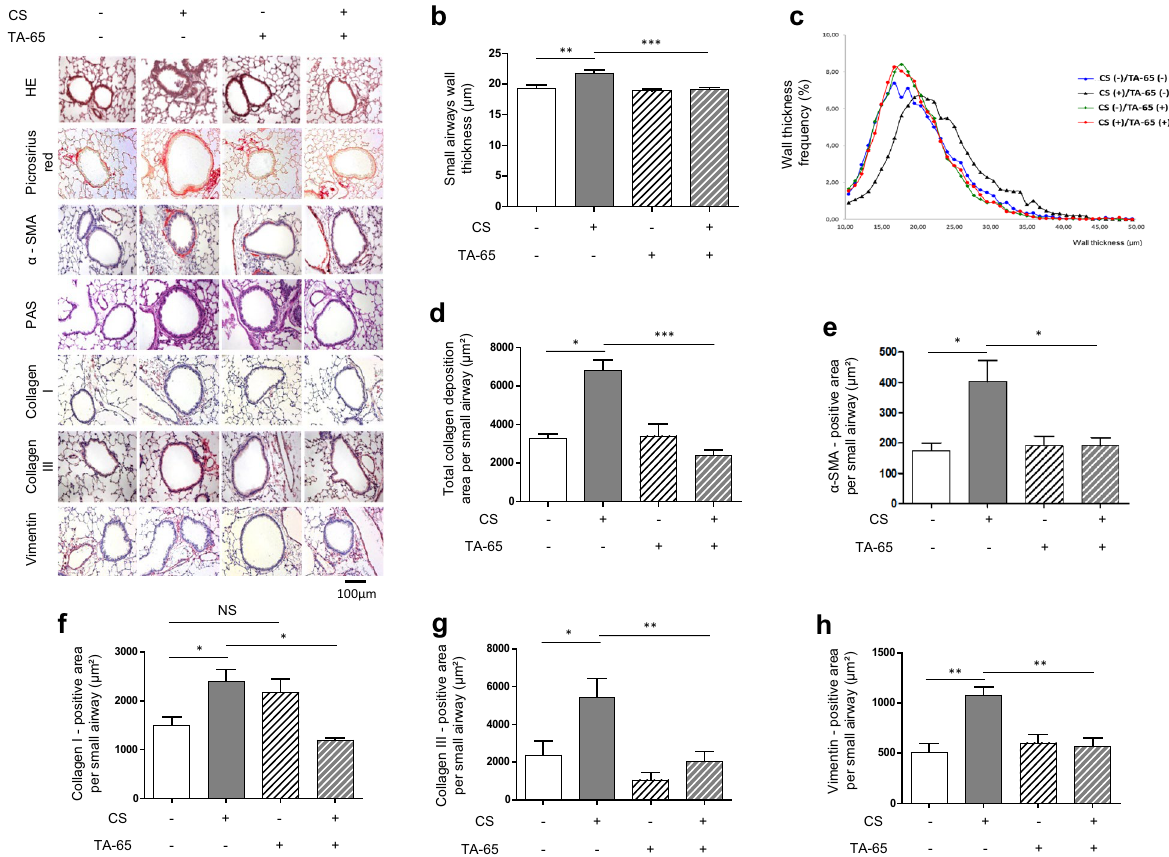
Figure 1. TA-65 effects on cigarette smoke-induced small airway remodeling. Representative lung tissue sections of mice exposed to air or cigarette-smoke (CS) with or without TA-65, and stained for HE, picrosirius red, α-SMA, PAS, Collagen I, Collagen III, or Vimentin ( a ). Quantification of small airways wall thickness by manual [( b ), in mean] or automated method [( c ), distribution], α-SMA expression ( d ), PAS staining ( e ), Collagen I ( f ), Collagen III ( g ) and Vimentin ( h ) expression. Original magnification, ×20. n = 7–8 mice per group. Data are presented as mean ± SEM. *p < 0.05, **p < 0.01, ***p <